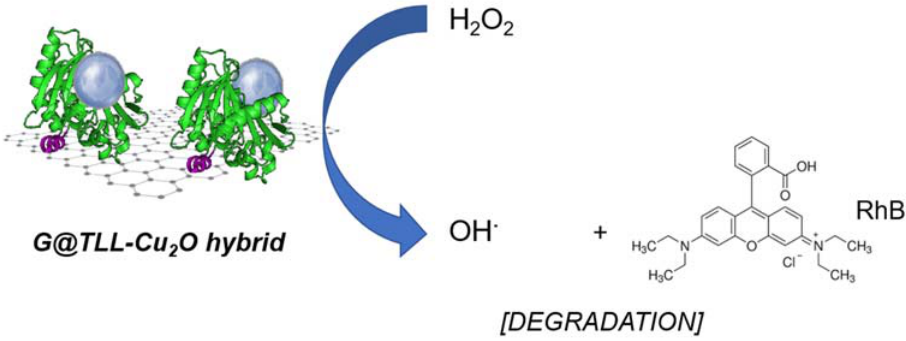
Figure 4. Degradation of 0.1 mM (48 ppm) of RhB at r.t. and natural light. ( A ) Effect of the amount of H 2 O 2 with 5 mg of G@TLL ‐ Cu 2 O hybrid; ( B ) Effect of the amount of G@TLL ‐ Cu 2 O hybrid with 250 mM of H 2 O 2 ; ( C ) Effect of medium pH, conditions: 50:50 ACN:Buffer with 5 mg of G@TLL ‐ Cu 2 O hybrid and 250 mM of H 2 O 2 .